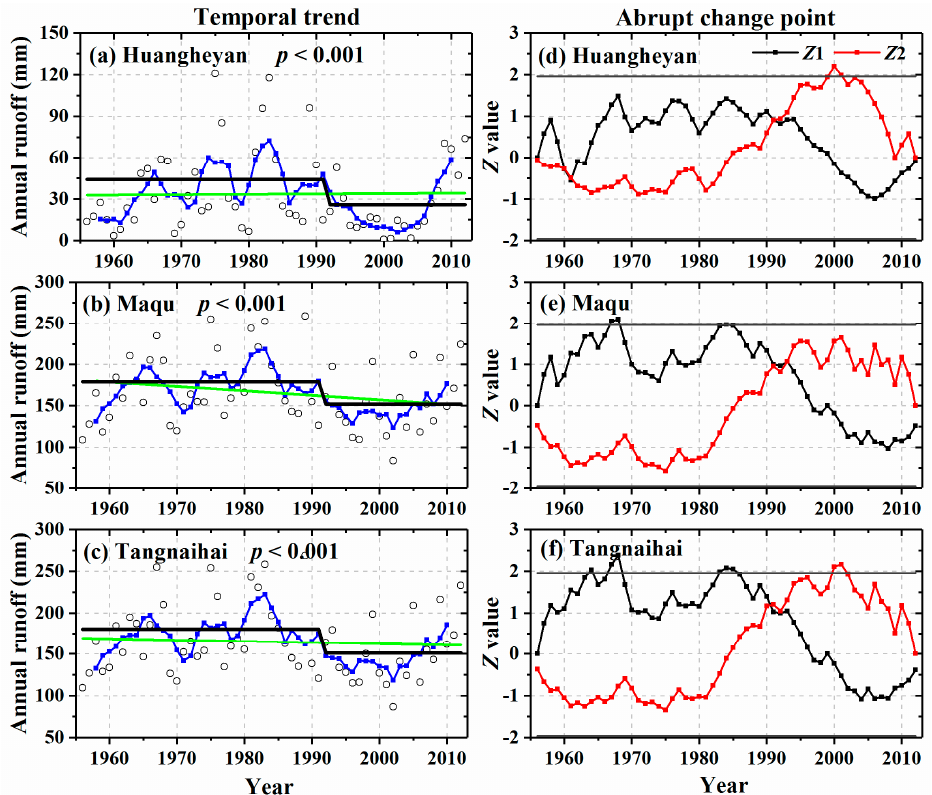
Figure 2. Temporal trends ( a – c ) and abrupt change points ( d – f ) based on the Mann-Kendall (M-K) abrupt change test for the annual runoff time series during the period of 1956–2012 for the Huangheyan, Maqu, and Tangnaihai stations, located at points across the HRYR. The white circles show annual runoff values (in a–c), the green and blue lines (in a–c) show the long-term linear tendency and the 5-year moving average for the annual runoff, respectively. The black line (in a–c) shows the long-term average runoff for the periods before and after the year identified by the M-K abrupt change test. Z1 and Z2 (in d–f) are confidence lines at a significance level of p = 0.05. The abrupt change point according to the M-K test lies at the intersection between these lines.